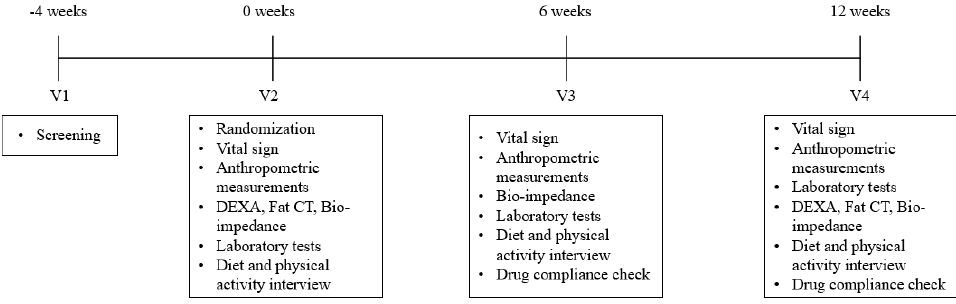
Figure 1. Overview of the study design.